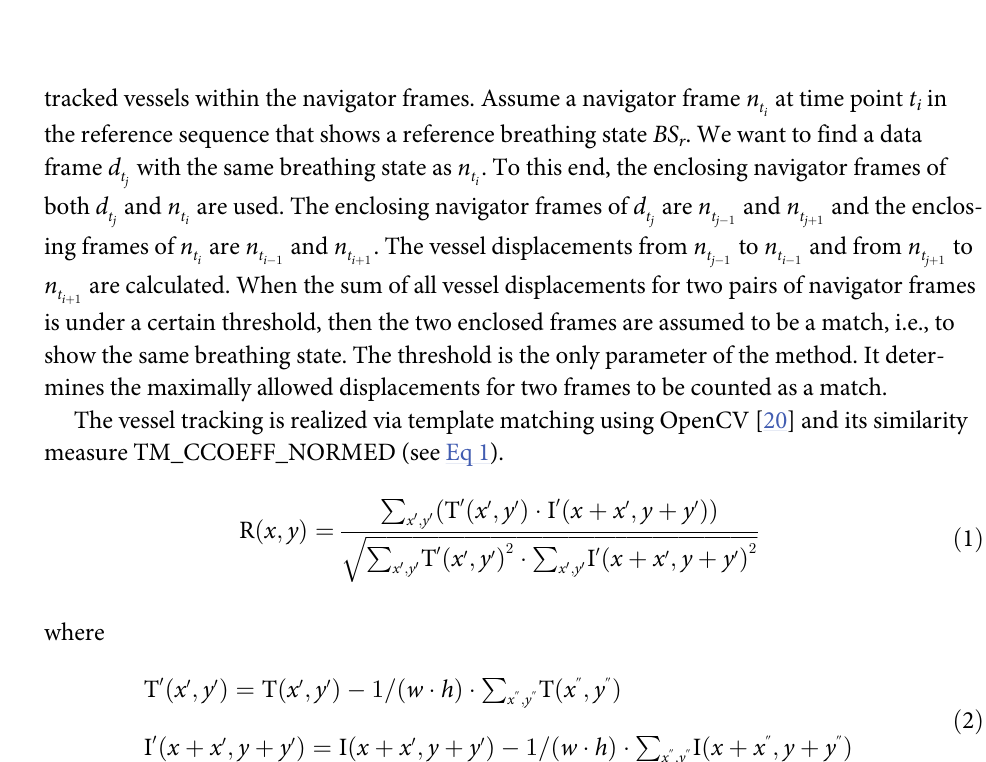
Fig 5. Scheme of finding data slices that match specific breathing state. On the left hand, the reference sequence is depicted. The red bracket represents the third breathing state. It is found in the interleaved sequence, depicted on the right, by comparing the enclosing navigator slices.